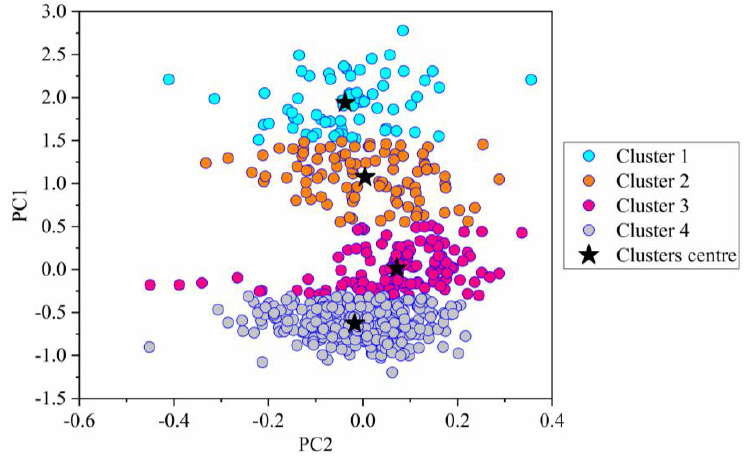
Figure 7. Scatter plot of the first two principal components (PC1, PC2) of four spectral clusters in the calibration dataset ( n = 640).